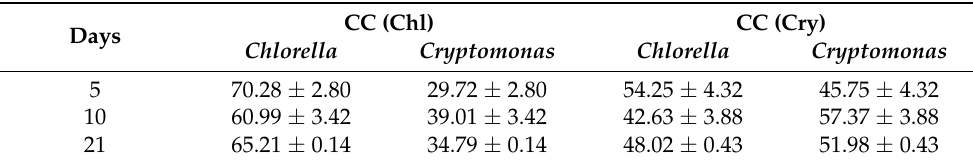
Table 6. Estimation (M ± SD, %) of the diet of Daphnia galeata by the QFASA model using extended- dietary subset of FAs (12:0, 14:0, 16:0, 16:1n-9, 16:1n-7, 16:2n-6,16:2n-4, 16:3n-3, 16:4n-3, 18:0, 18:1n-9,